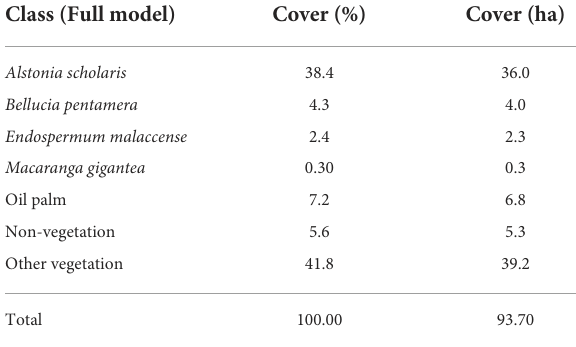
TABLE 3 Abundance of species predicted across the Harapan landscape, with the oil palm plantation in the North and regions of forest clearance removed as shown in Supplementary Figure